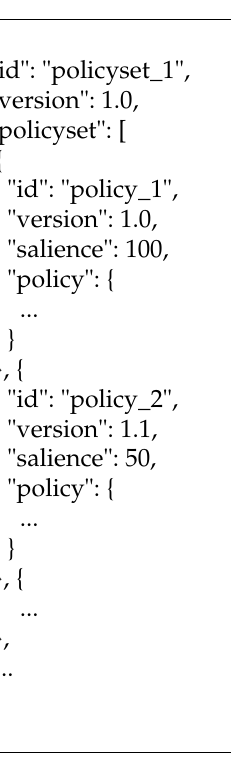
Figure 8. A list of policies evaluated in order defined by the salience